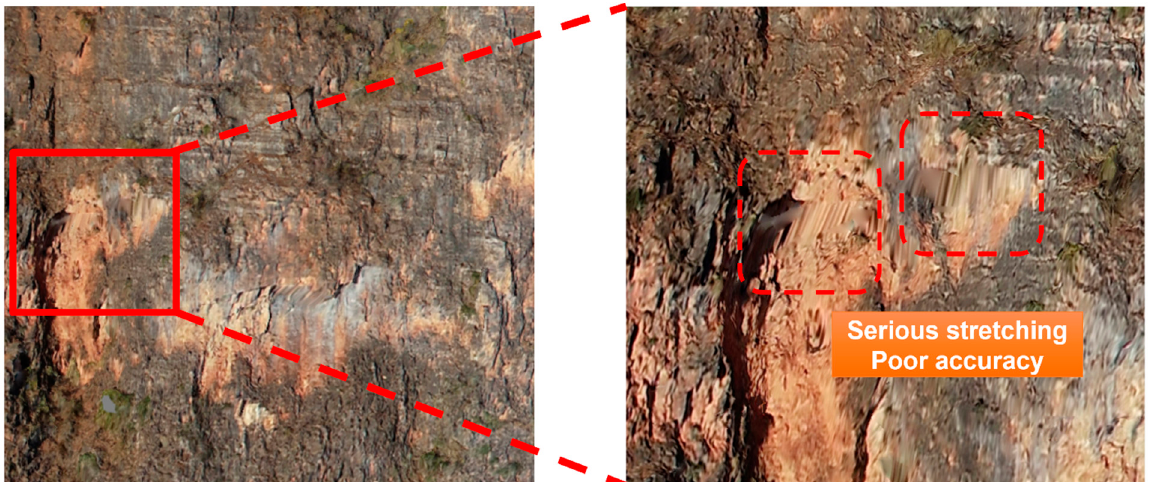
Figure 6. UAV photogrammetry data acquisition: ( a ) 3D model of UAV; ( b ) 3D LAS point cloud of UAV.